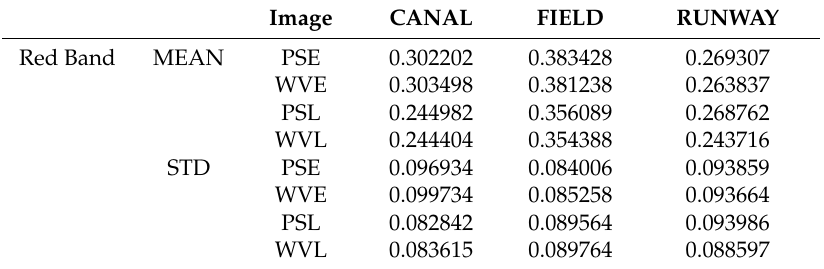
Table 1. Means and stds of Red band of two image pairs for the three scenarios in Section